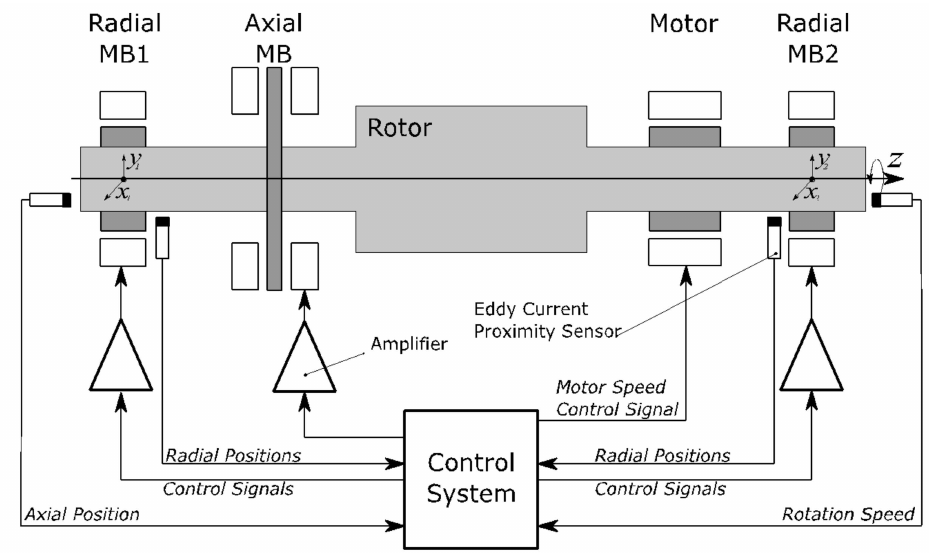
Figure 1. AMB rotor